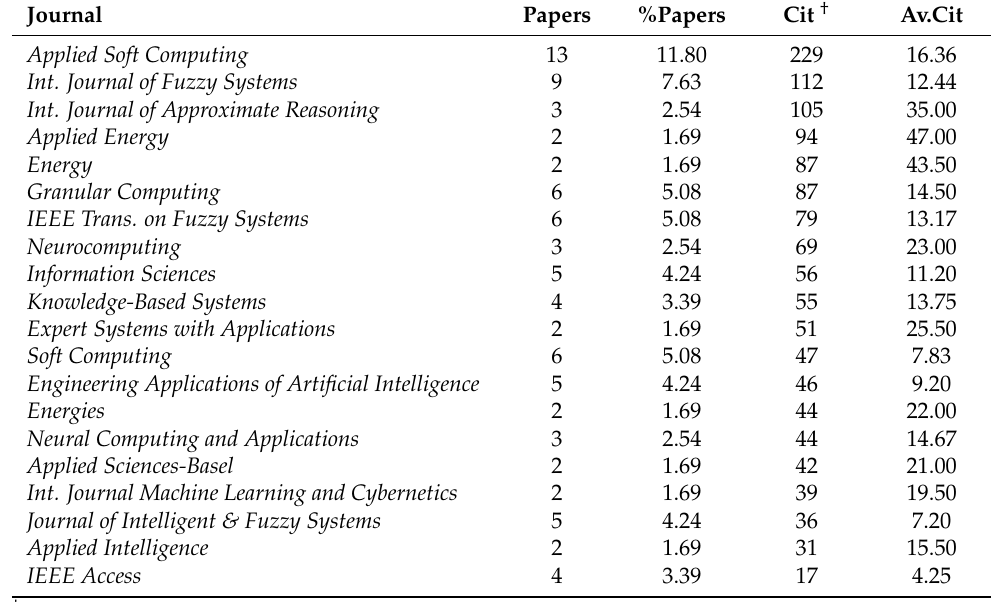
Table 2. Analysis of the top 20